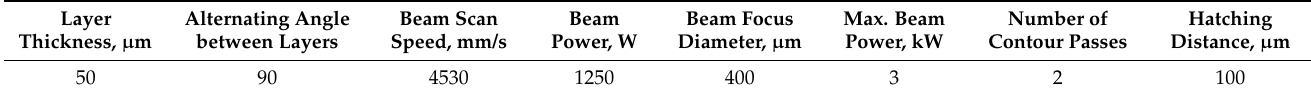
Table 2. Arcam EBM process parameters.